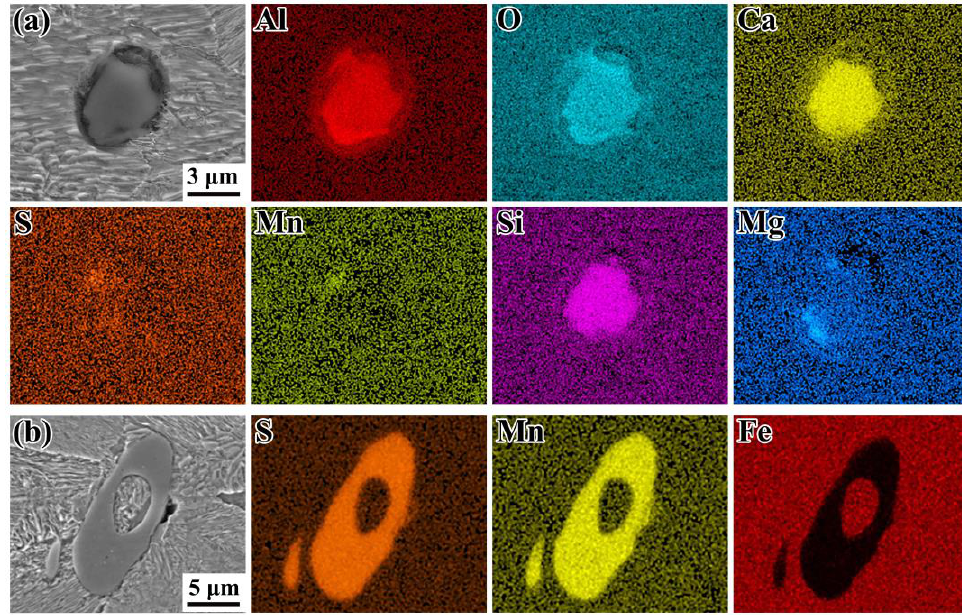
Figure 5. SEM images and EDX (energy dispersive X-ray analysis) maps of the oxysulfides: ( a ) Al 2 O 3 surrounding oxide, ( b ) elongated MnS inclusion.